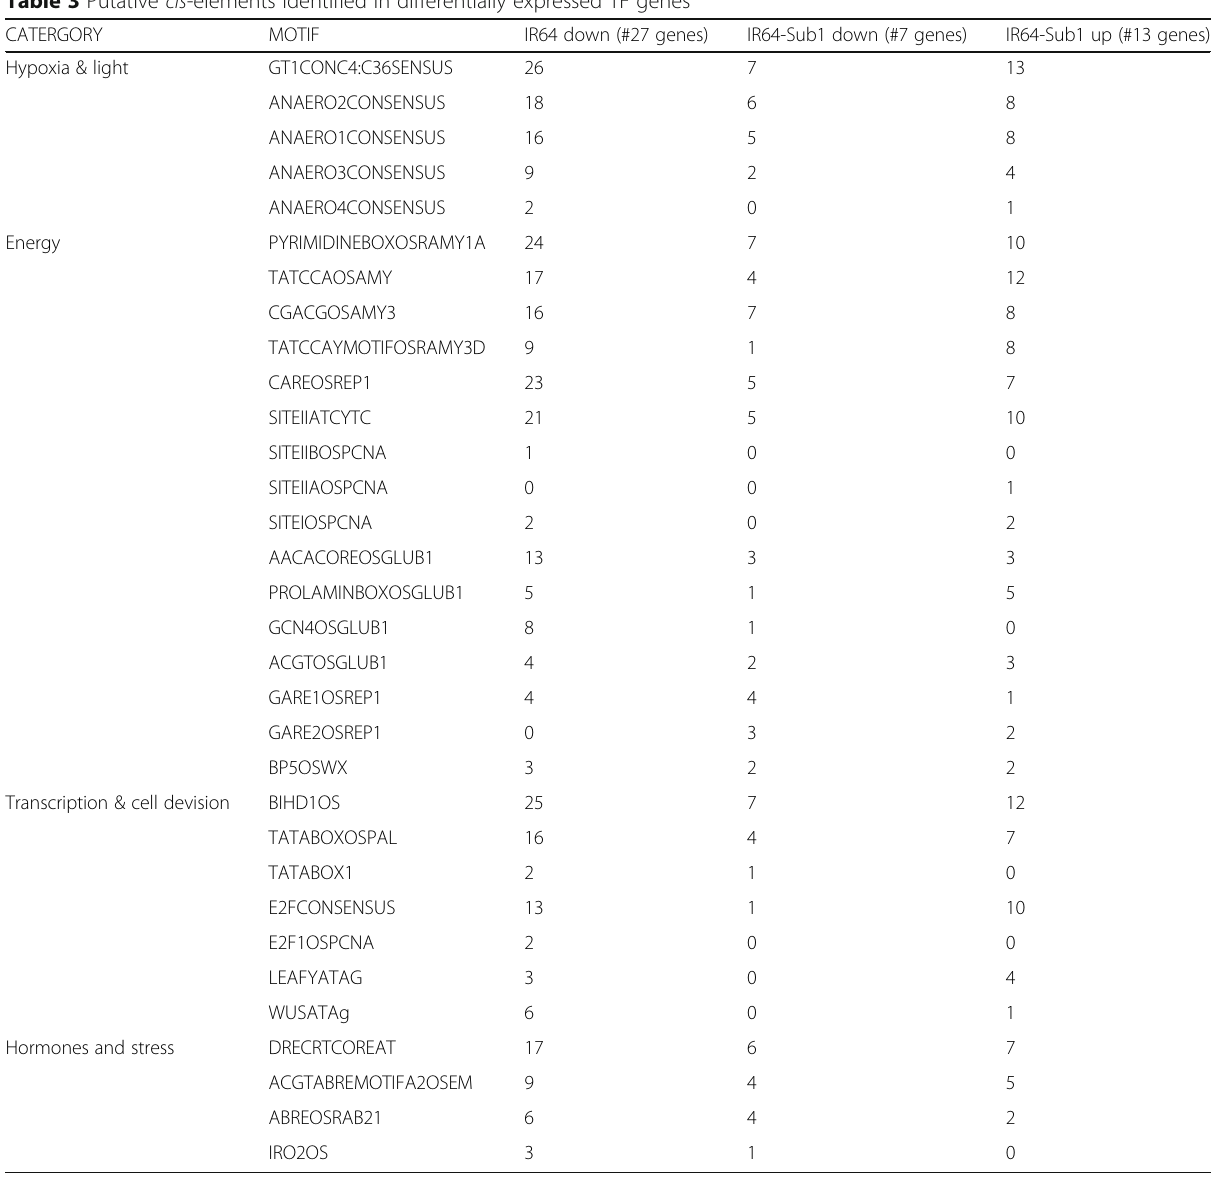
Table 3 Putative cis -elements identified in differentially expressed TF genes CATERGORY MOTIF